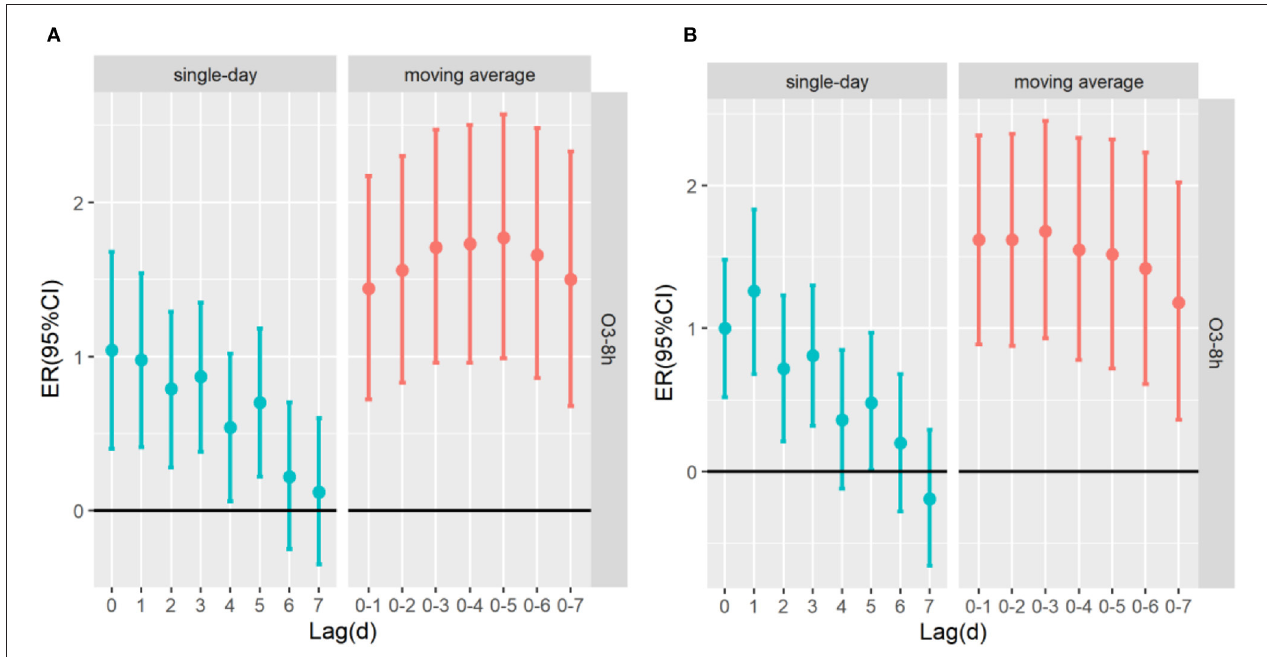
FIGURE 4 | The ER (95%CI) of mortality associated with 10 µ g/m 3 increase of O 3 -8h concentration; (A) O 3 -8h lead to respiratory mortality; (B) O 3 -8h lead to cardiovascular mortality.